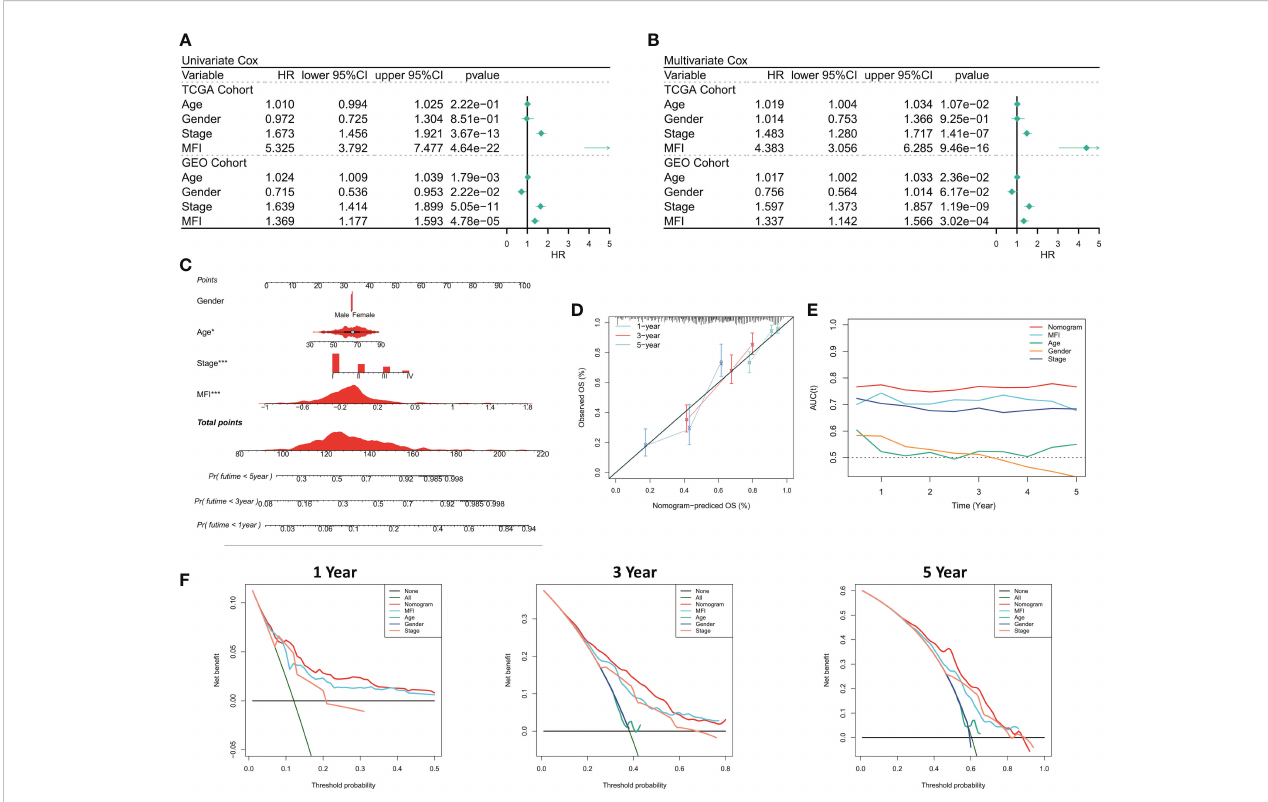
FIGURE 4 Assessing the predictive independence of MFI. (A) One-factor COX regression analysis of OS in TCGA and GEO cohorts. MFI was an independent prognostic indicator in both the training and validation sets; (B) Multi-factor COX regression analysis of OS in the TCGA and GEO cohorts. After correcting the other three common clinical variables, multifactorial cox still suggests MFI as a signi fi cant independent prognostic factor; (C) Quanti fi cation the risk of individual patients via Nomogram to predict the survival at 1, 3, and 5 years; (D) Calibration curves of Nomogram at 1, 3, and 5 years. The results revealed satis fi ed stability and accuracy of Nomogram model at 1, 3 and 5 years; (E) tROC curves of Nomogram. Nomogram model was a better predictor compared to clinical characteristics; (F) DCA curves of Nomogram at 1, 3 and 5